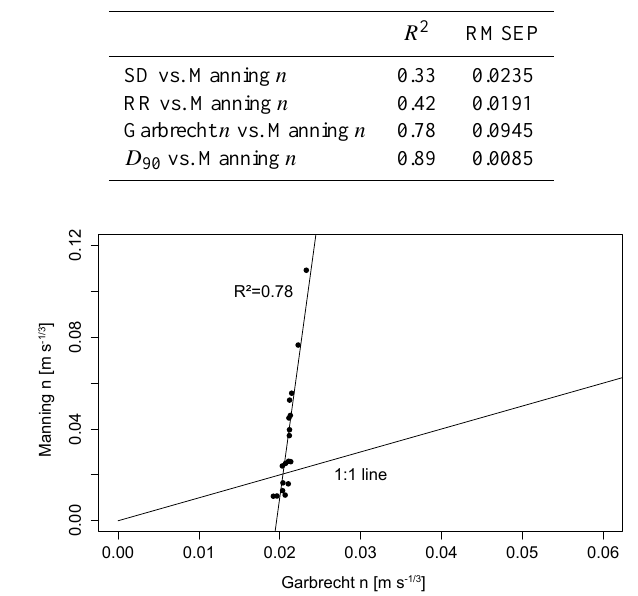
Table 2. Comparison of different roughness parameters and their coefficients of determination and RMSEP with Manning’s n (hy- draulic roughness).